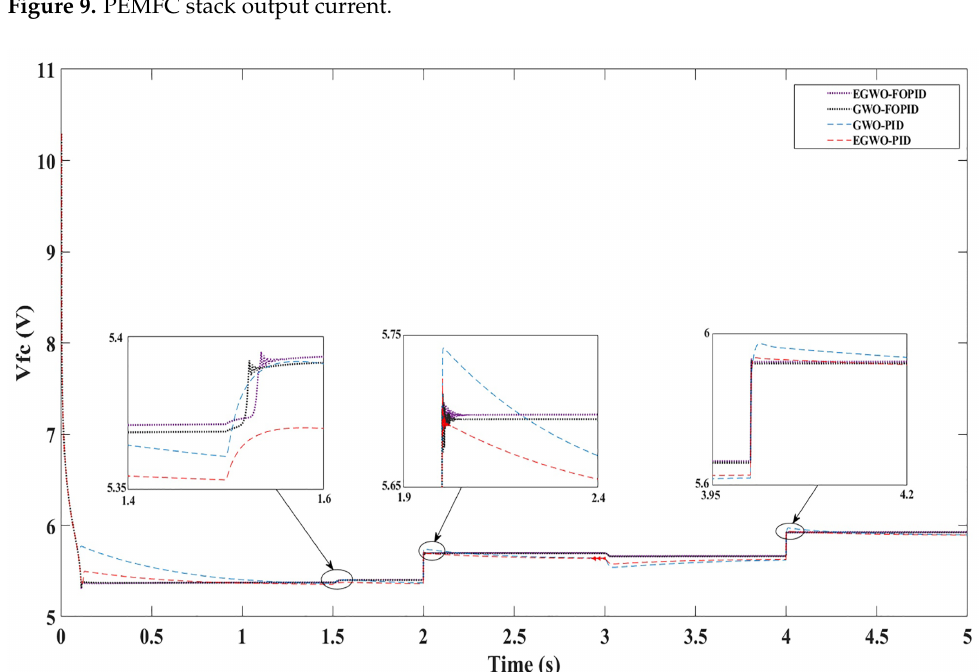
Figure 10. PEMFC stack output